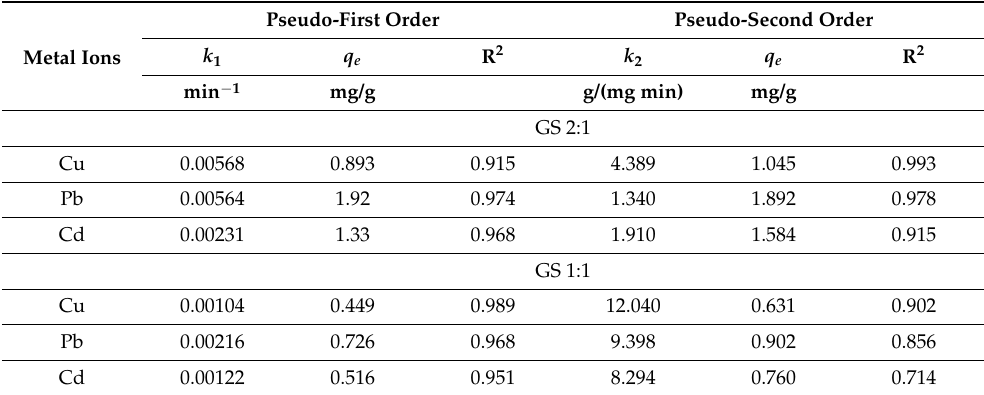
Table 3. The adsorption rate constants ( k 1 , k 2 ), maximum adsorption capacity ( q e ) and correlation coefficients (R 2 ) for pseudo-first order and pseudo-second order